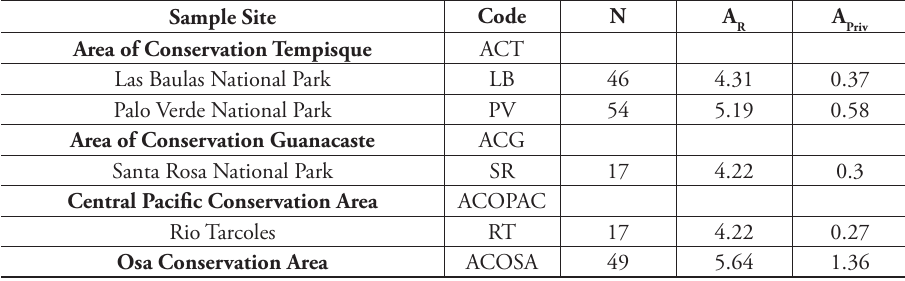
Table 2. Genetic variability estimates for Crocodylus acutus populations in Pacific Costa Rica.